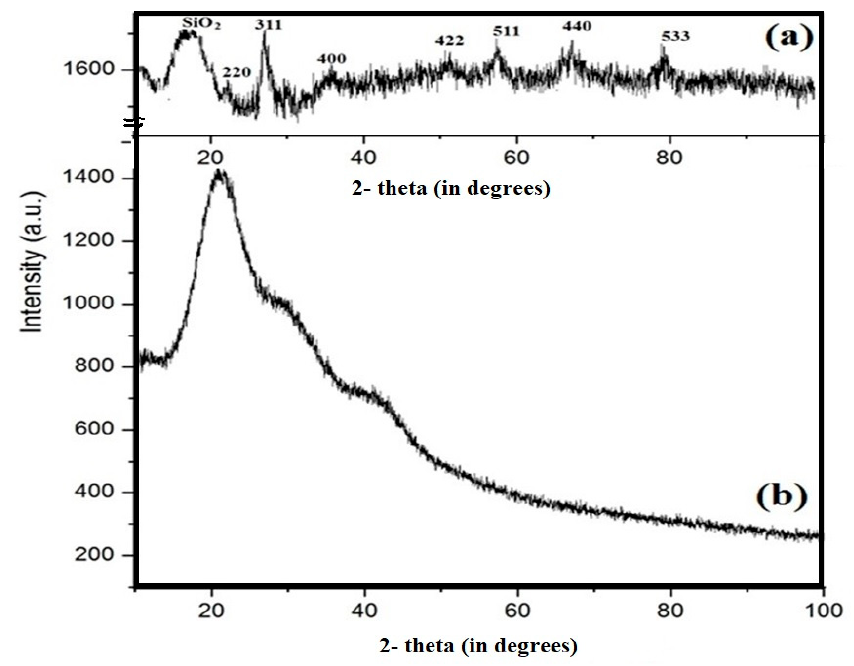
Figure 7. XRD di ff ractograms of ( a ) Fe 3 O 4 -Si-IL and ( b ) Si-IL. Figure 7. XRD diffractograms of ( a ) Fe 3 O 4 -Si-IL and ( b ) Si-IL. Figure 7. XRD diffractograms of ( a ) Fe 3 O 4 -Si-IL and ( b ) Si-IL.